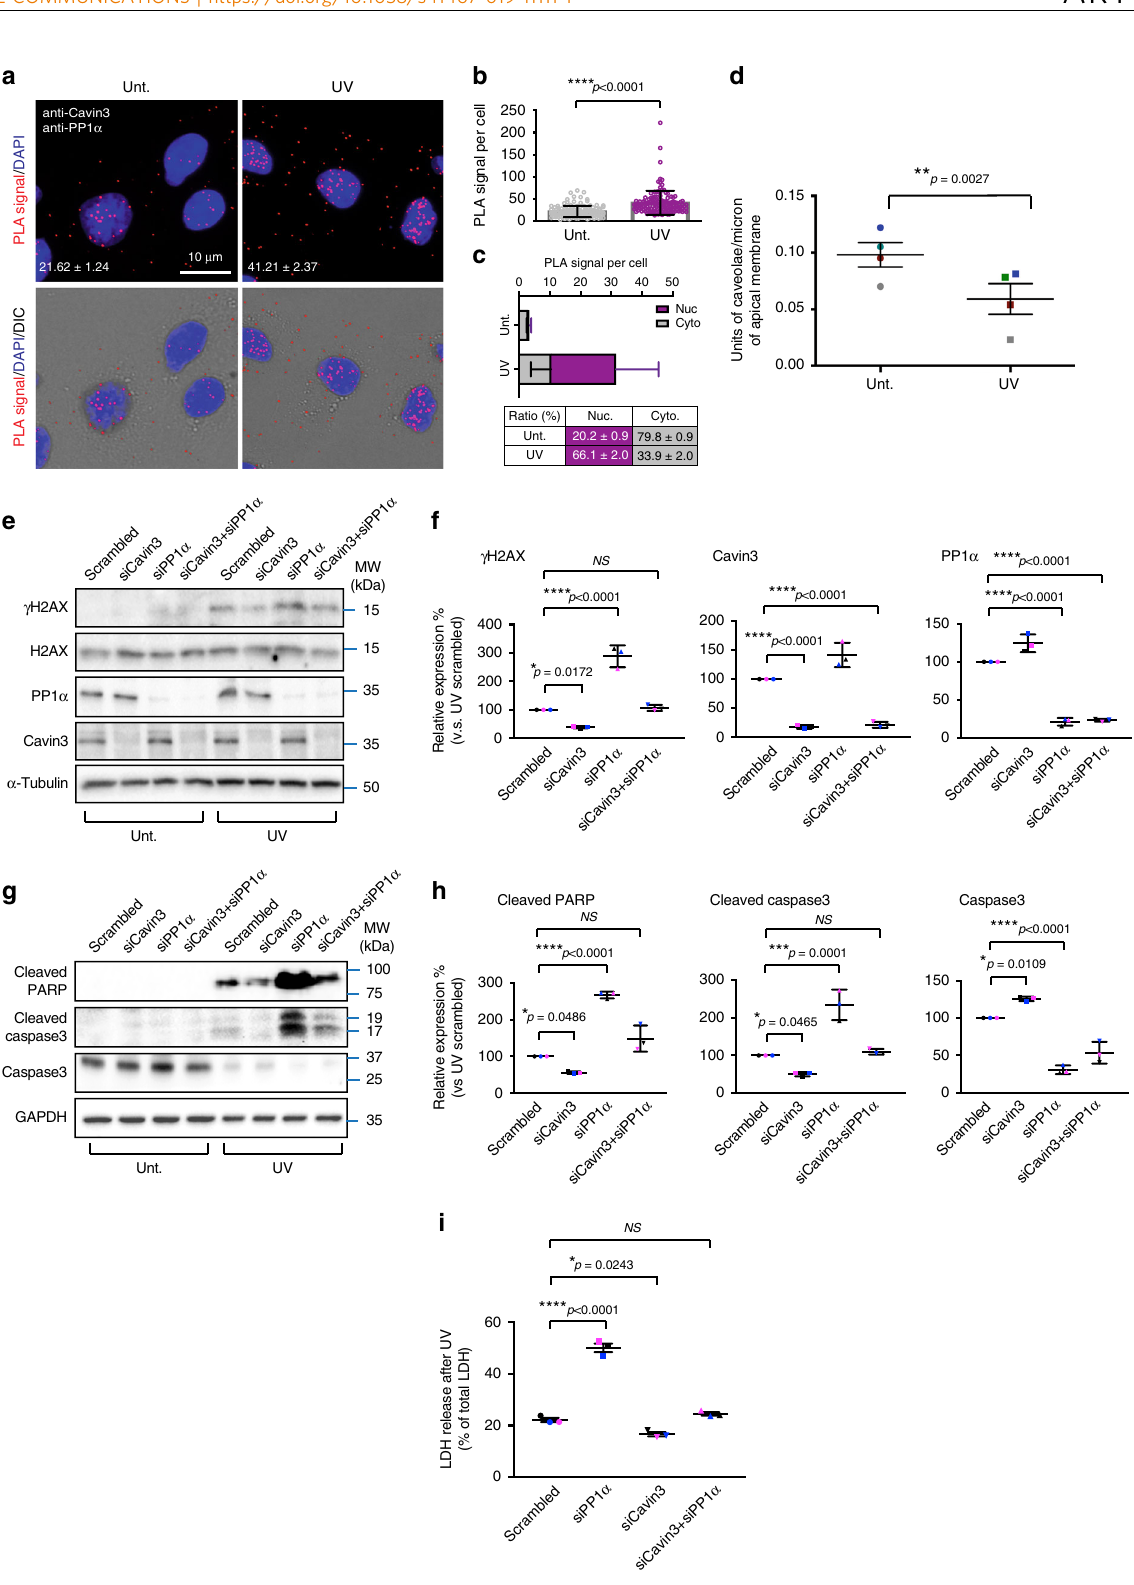
(quanti fi cation in Fig. 6b), suggesting that PP1 α phosphatase activity contributes to the dephosphorylation of γ H2AX upon UV treatment. We further examined whether Cavin3 and PP1 α form a complex with γ H2AX using a GFP Trap pulldown in control or UV-treated A431 cells transfected with PP1 α -GFP or Cavin3- GFP. γ H2AX was speci fi cally coprecipitated by either PP1 α -GFP NATURE COMMUNICATIONS| (2019) 10:3279